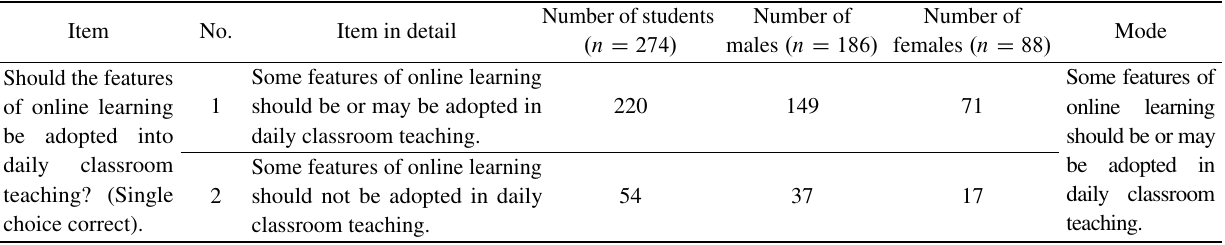
Table 5 Students from three institutions respond to the adoption of e-learning practices in daily classroom